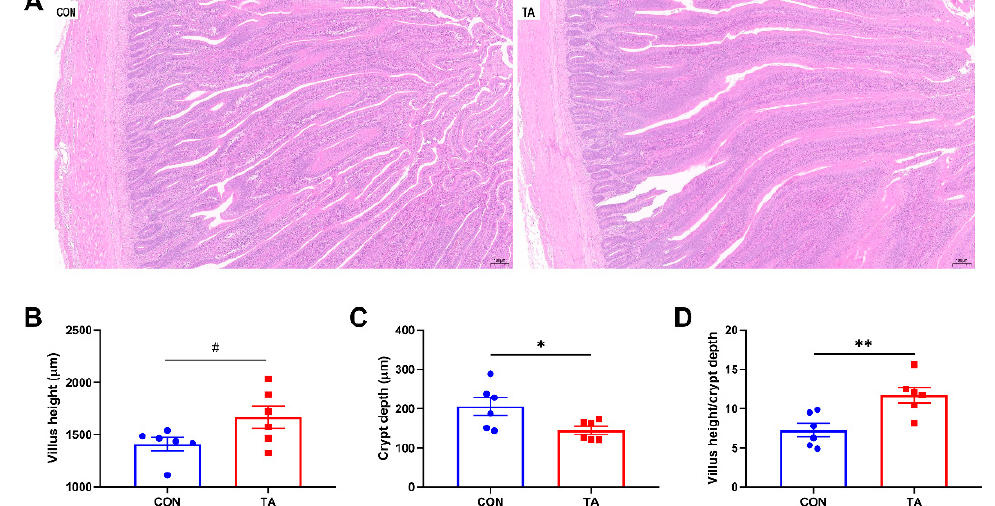
Figure 2. Effects of tannic acid extracted from Galla chinensis supplementation on intestinal morphol- ogy in broiler chickens. ( A ) Hematoxylin and eosin photomicrographs obtained at 100 × magnifica- tion; ( B ) Villus height; ( C ) Crypt depth; ( D ) Villus height/crypt depth ratio. CON, broiler chickens fed basal diet; TA, broiler chickens fed basal diet supplemented with 300 mg/kg microencapsulated tannic acid extracted from Galla chinensis . Values are mean ± standard error ( n = 6). Differences between treatments were displayed by # 0.05 ≤ p < 0.10, * p < 0.05, and ** p <